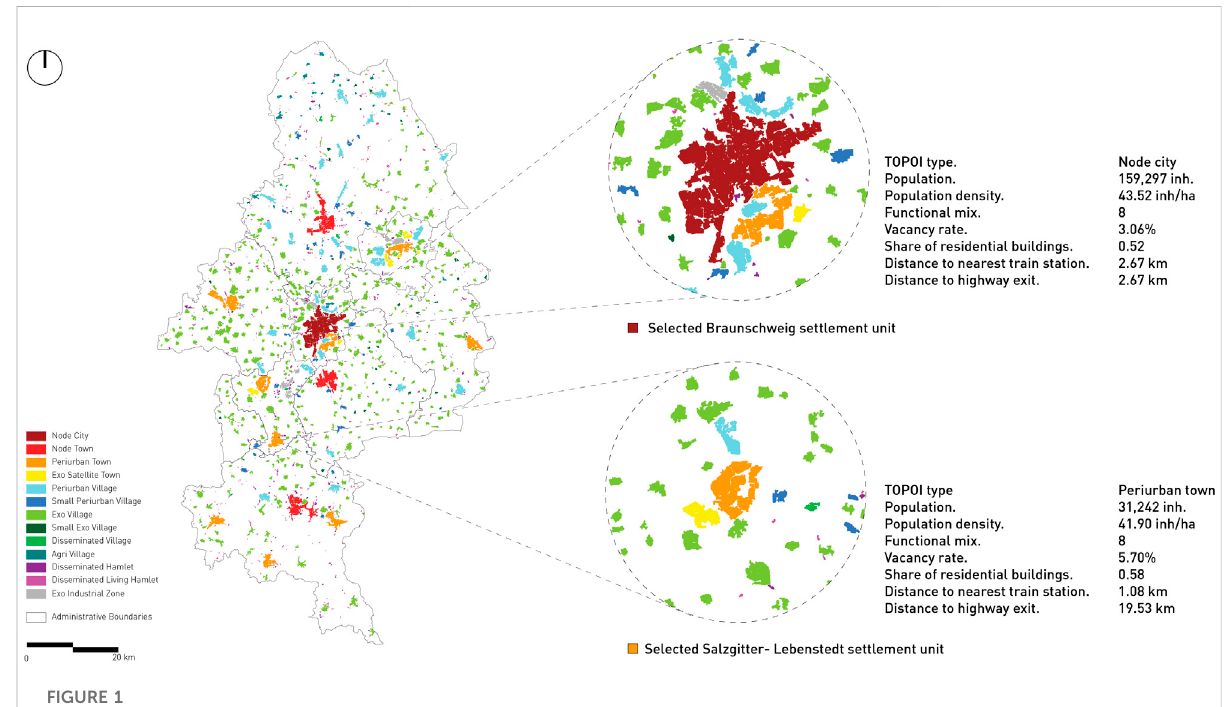
FIGURE 1 TOPOI method applied to the Larger Braunschweig